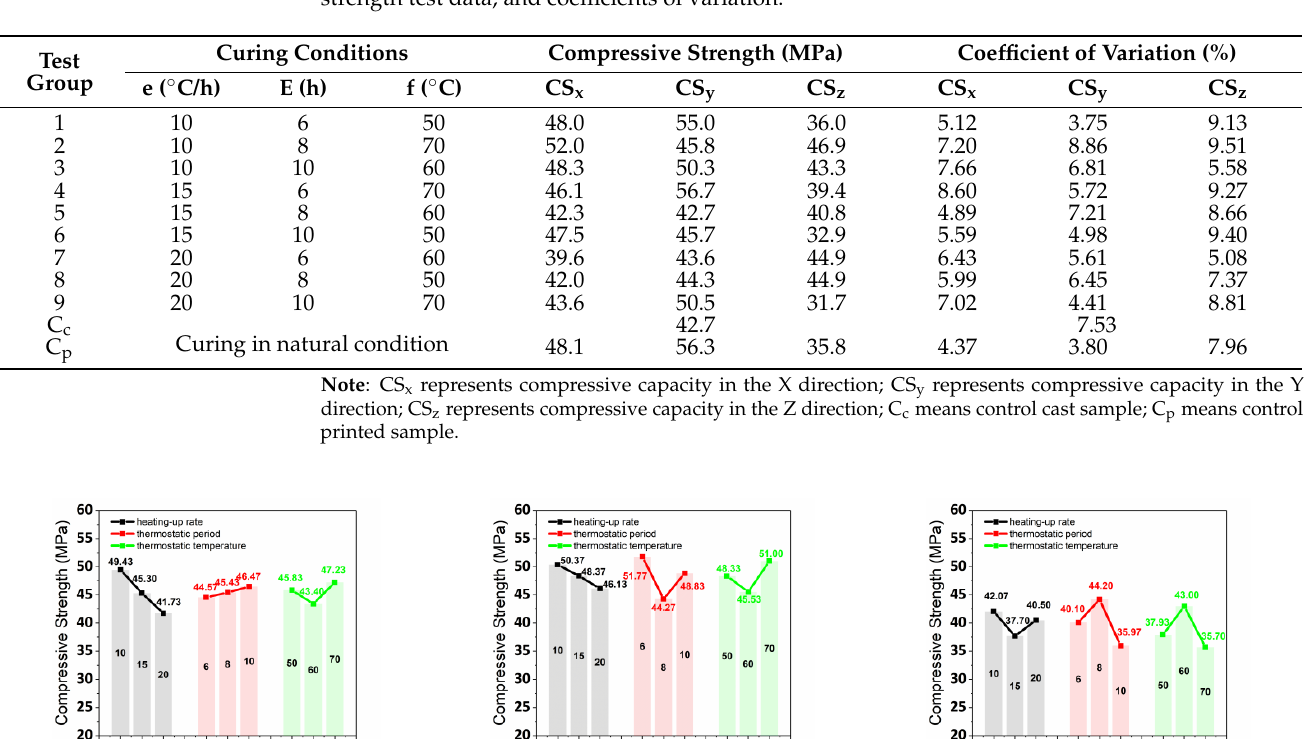
Table 5. Orthogonal experimental table of various test group designs, curing conditions, compres- sive strength test data, and coefficients of variation.